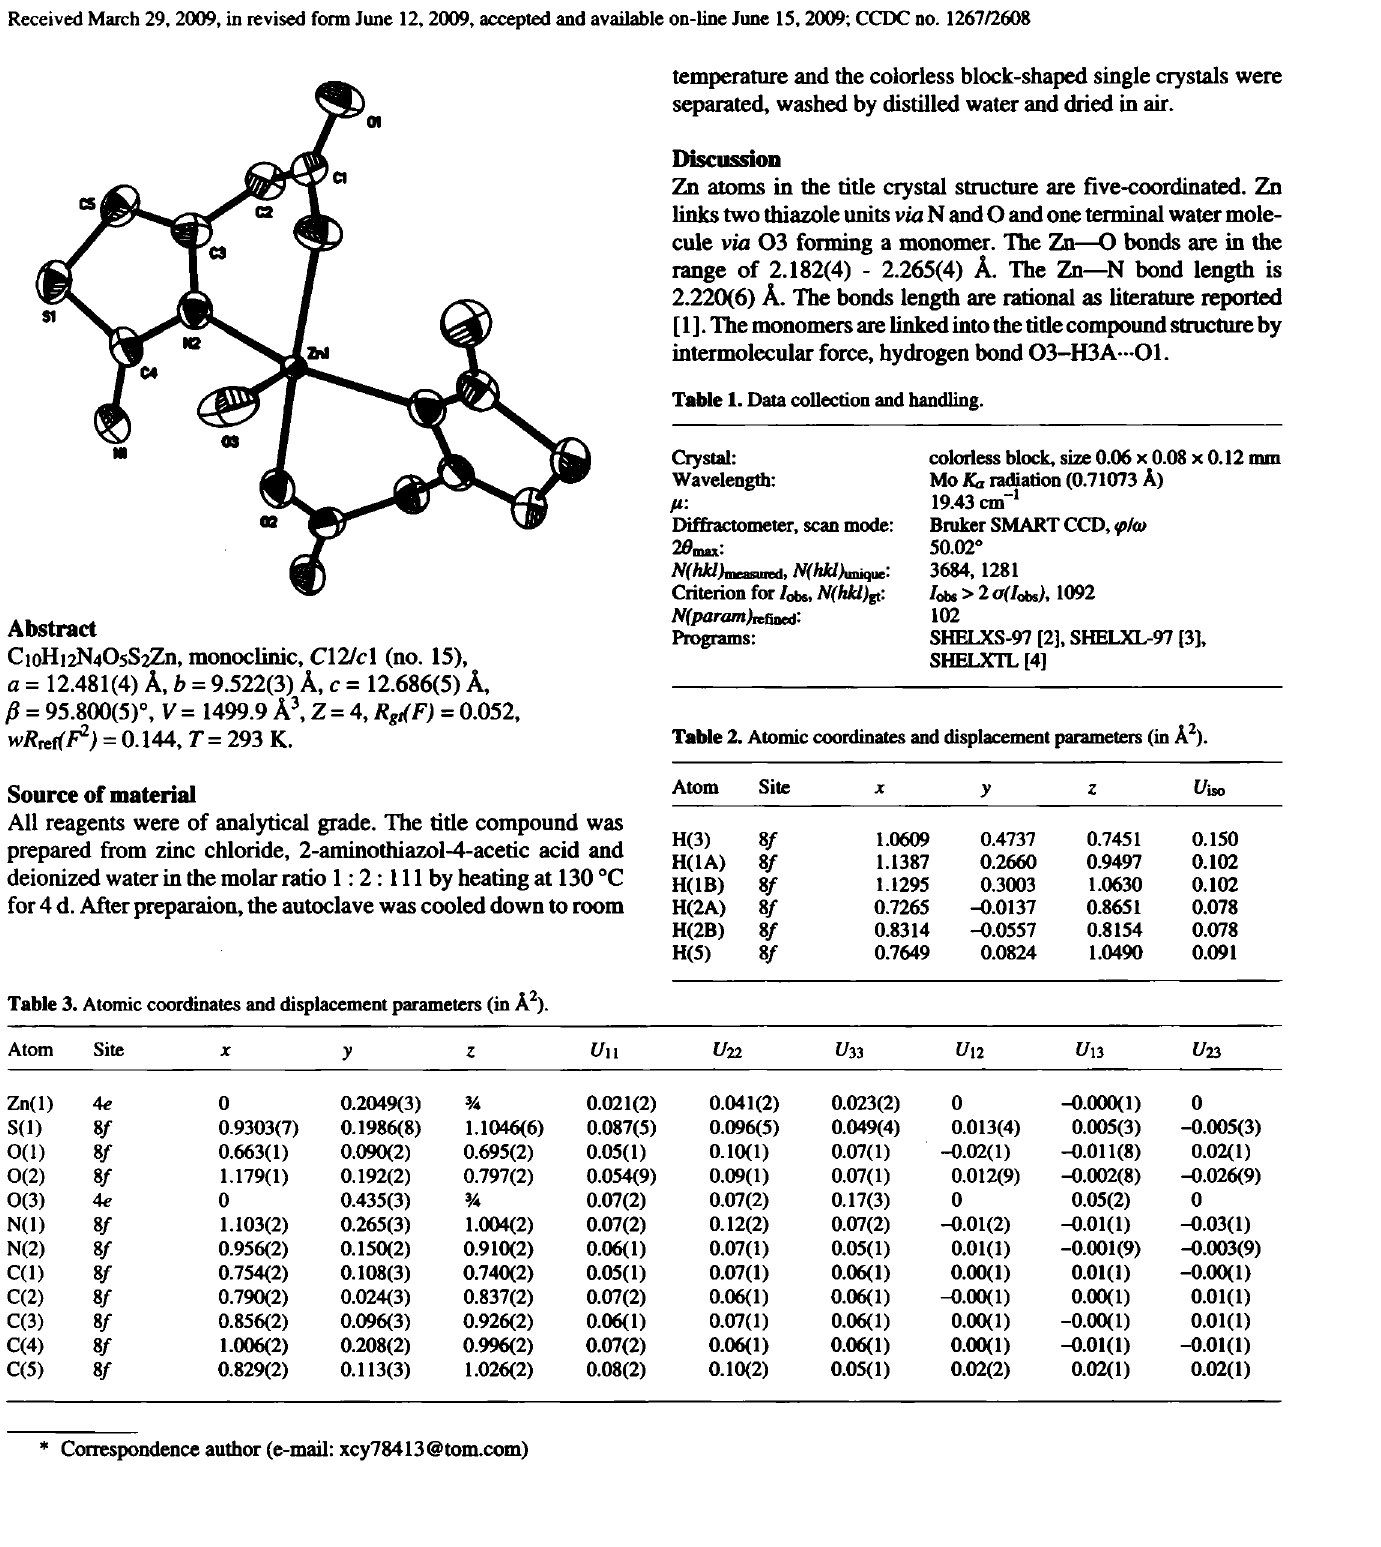
temperature and the colorless block-shaped single crystals were separated, washed by distilled water and dried in air.